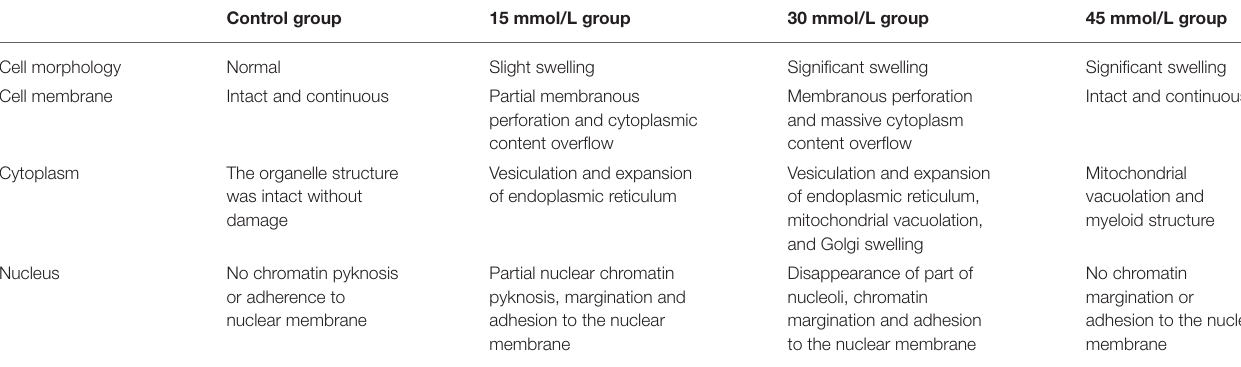
TABLE 1 | Comparison of HK-2 cell ultrastructure in different experimental